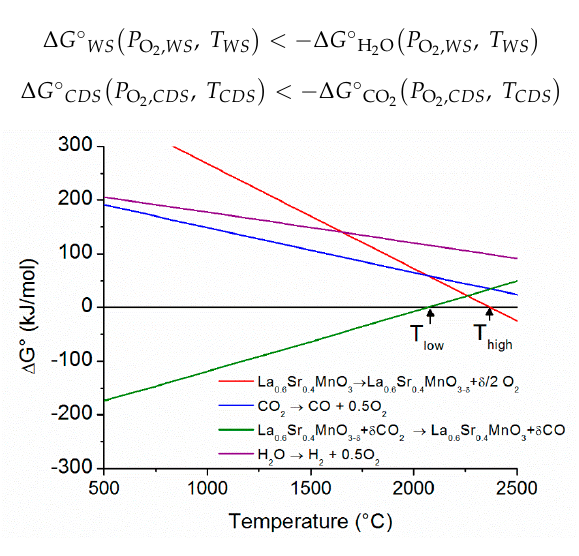
Figure 1. Schematic plot of the Gibbs energy for carbon dioxide splitting, water splitting, and two-step thermochemical redox cycling of La 0.6 Sr 0.4 MnO 3 in standard conditions.